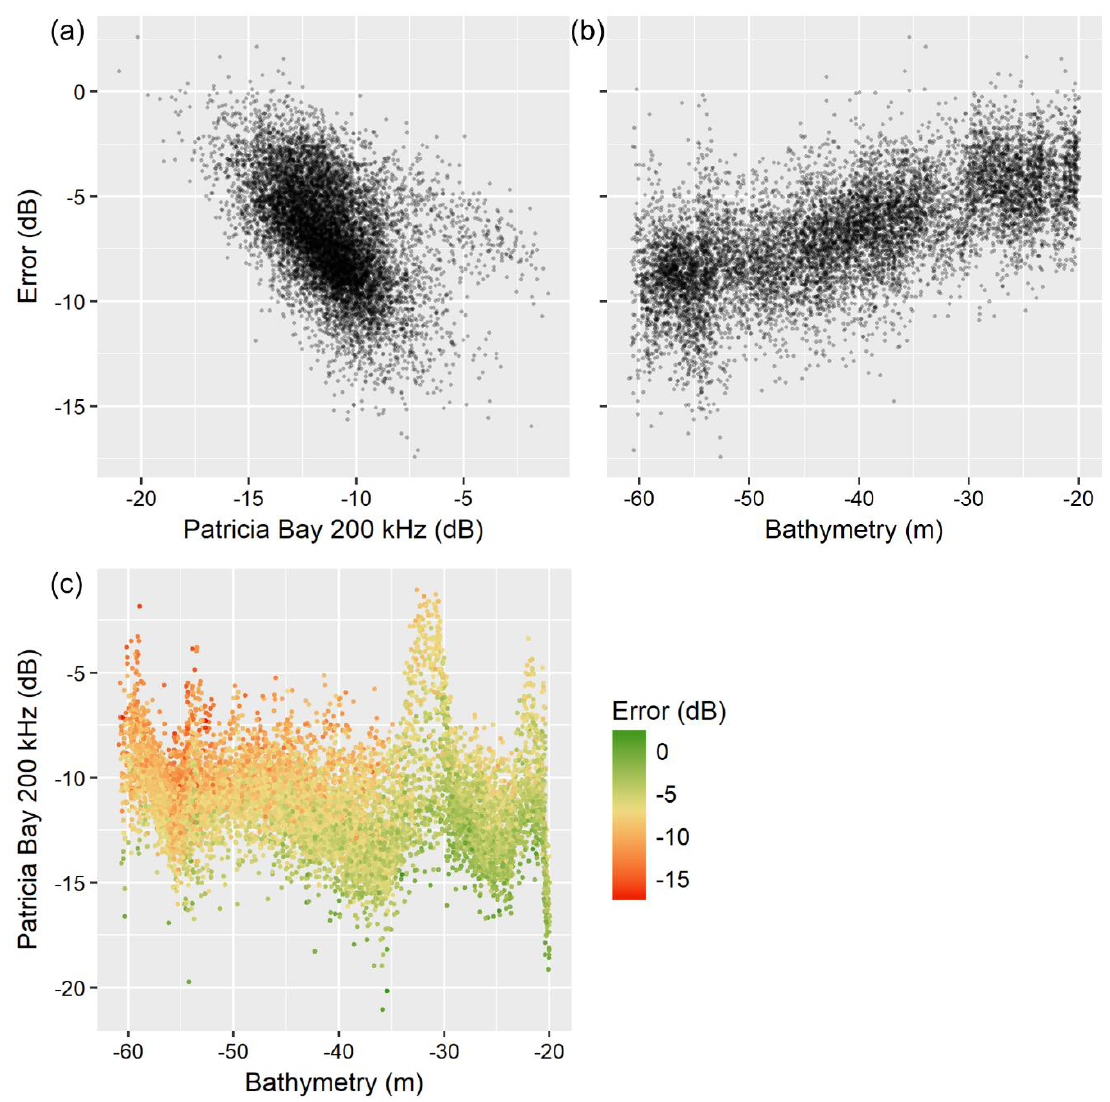
Figure 3. Error between 400 and 200 kHz Patricia Bay datasets as a function of ( a ) the 200 kHz backscatter, ( b ) bathymetry, and ( c ) both. Table 1. Bulk shift methods